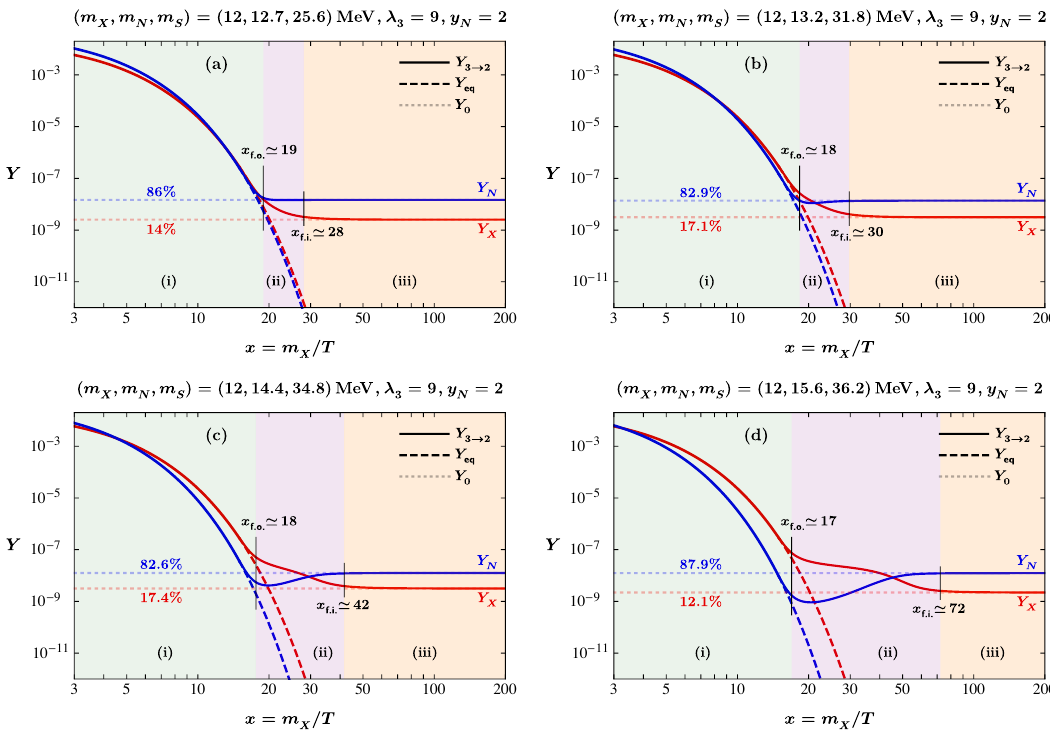
Figure 5 . The cosmological evolution of the comoving number densities of DM in the absence of the 2 → 2 processes for r > 1 in the r SIMP model. In region (i), the DM particles are in chemical N equilibrium via the 3 → 2 annihilations. In region (ii), the number densities of DM are out of the chemical equilibrium and keep changing (increased or decreased) before the freeze-in temperature of DM. Finally, the DM number densities are frozen until today in region